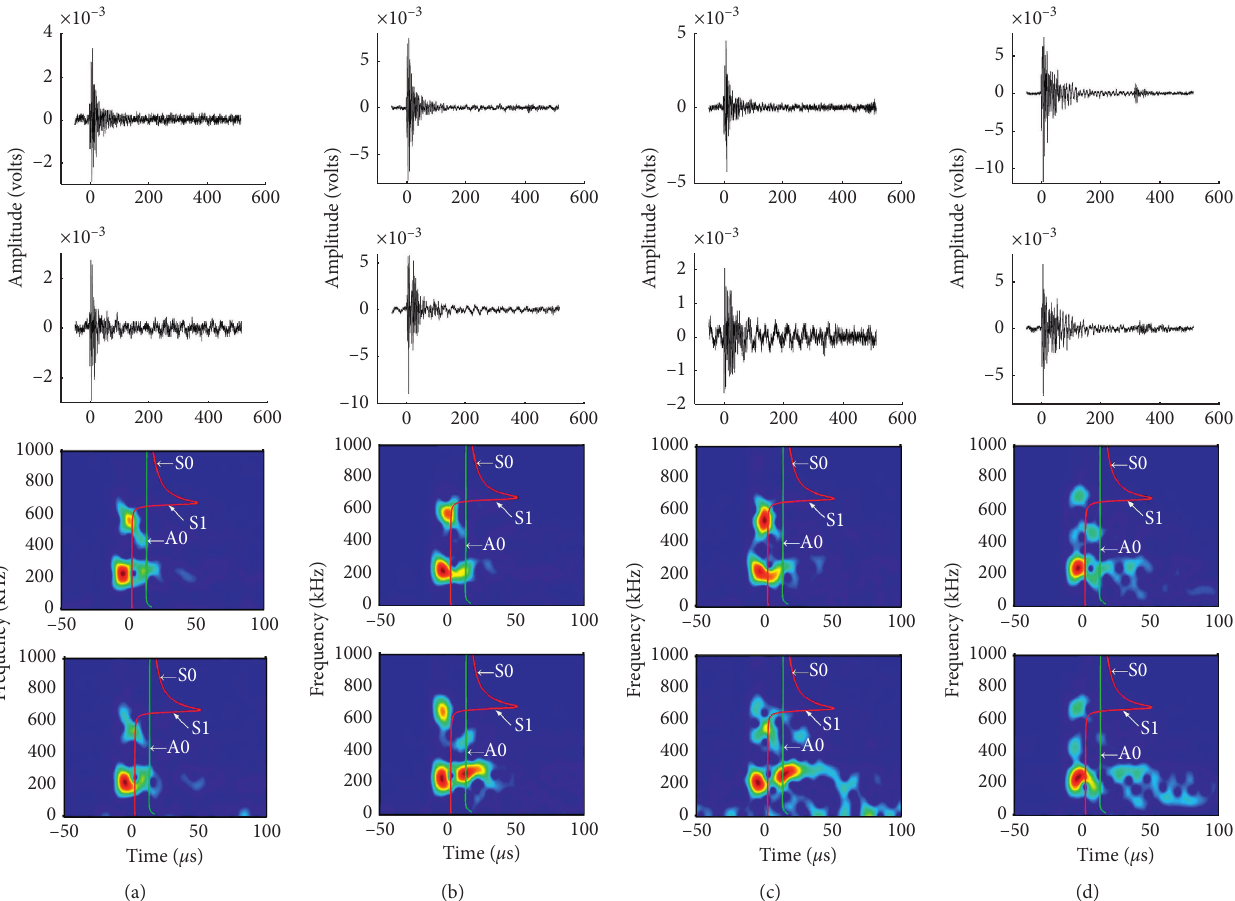
Figure 8: The AE signals and spectrograms in the [0/90/0/90/0